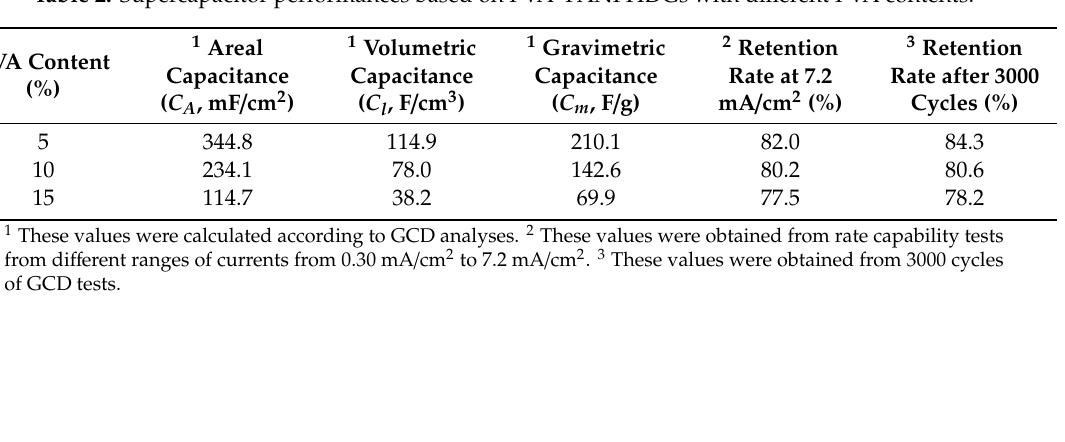
Table 2. Supercapacitor performances based on PVA–PANI HDGs with di ff erent PVA